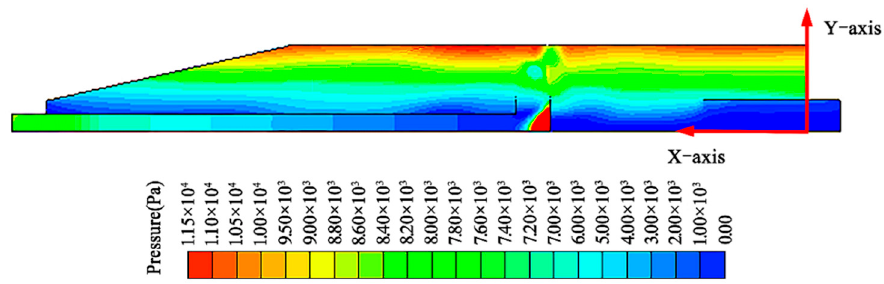
Figure 7. Pressure distribution of the central section (rotational speed is 900